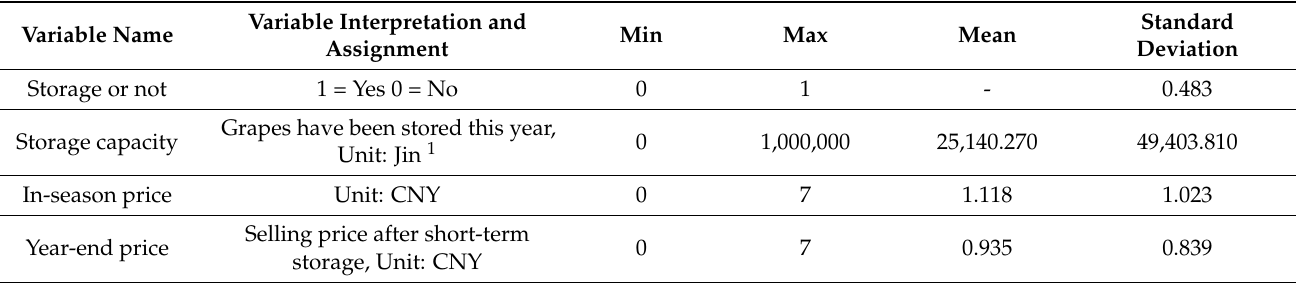
Table 1. Descriptive statistics of grape